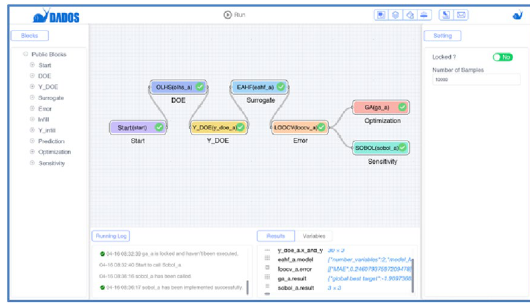
Figure 19 Configuration of the Sobol block for the numerical example